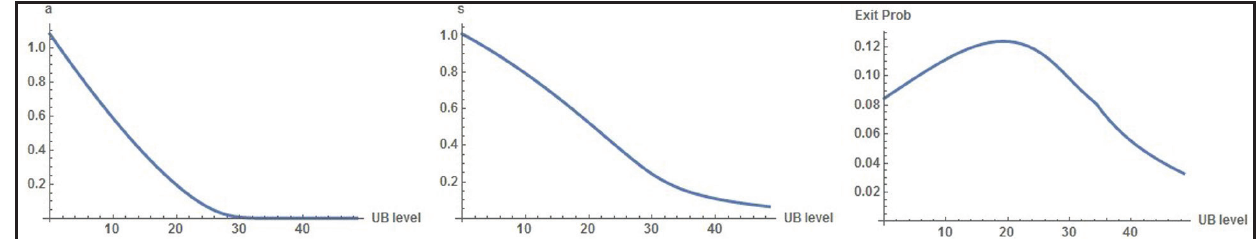
Stochastic Wage Offers [SWO]. The three graphs show the level of a respectively, at the start of the unemployment spell, in the model [SWO] for different values of b . The functions and parameters are those of Table 1, except for f , which is now equal to zero, and σ = 2. We set T = B = 200, the total quantity of time. We assume that wages are Pareto distributed with parameters w = 66.66 and α = min